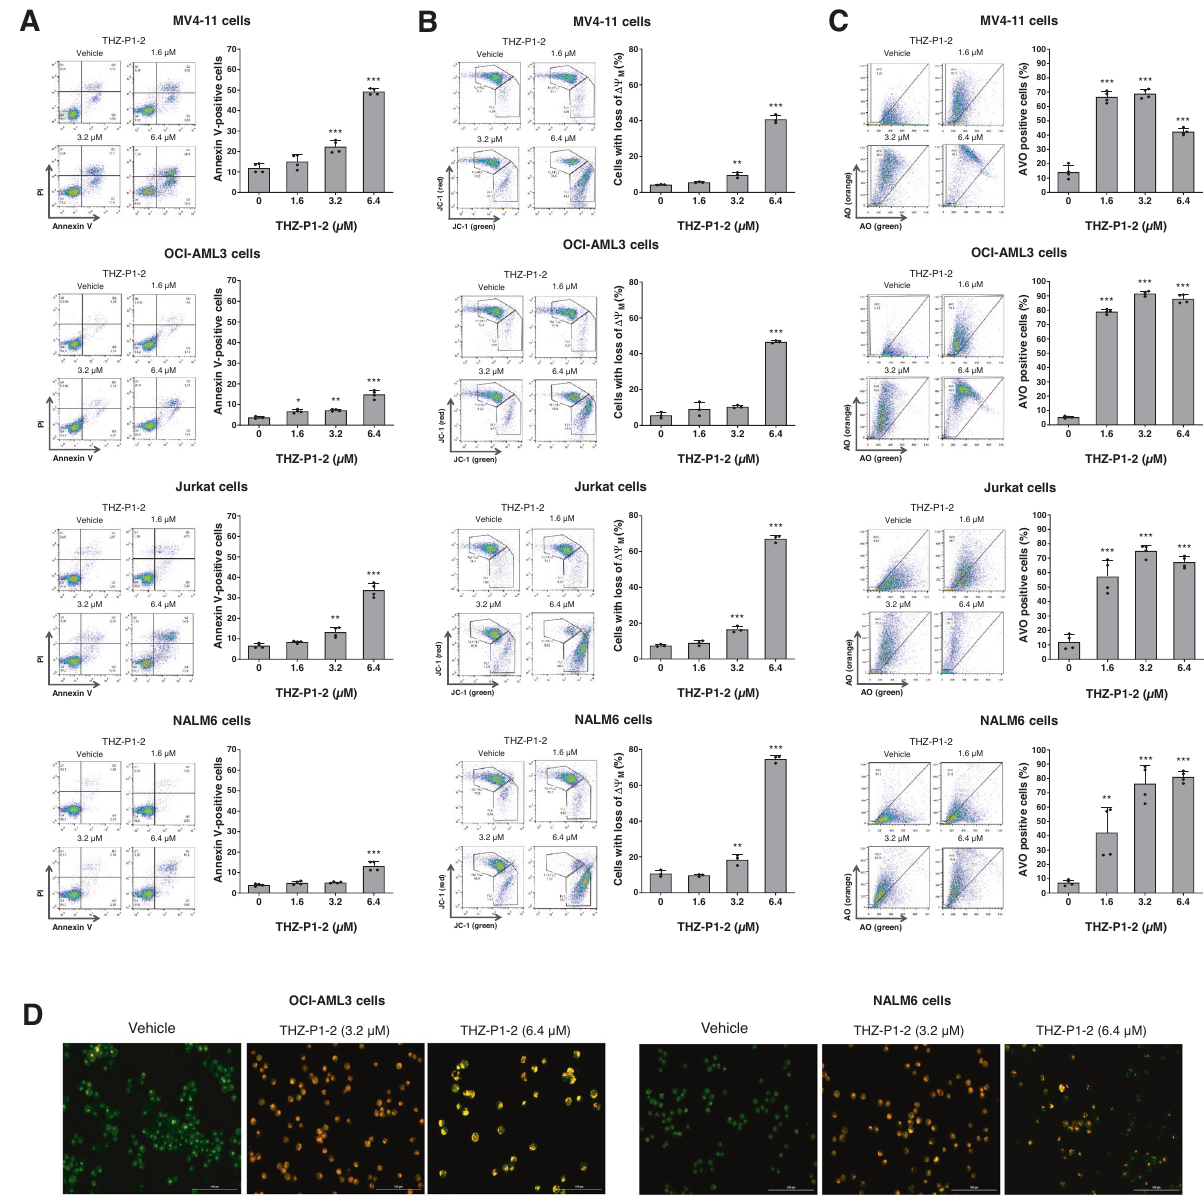
Fig. 2 THZ-P1-2 induces apoptosis and dysfunction in mitochondria and autophagic fl ux. A Apoptosis was detected by fl ow cytometry in MV4-11, OCI-AML3, Jurkat, and NALM6 cells treated with vehicle or with increasing concentrations of THZ-P1-2 (1.6, 3.2, and 6.4 μ M) for 24 h using an APC-annexin V/PI staining method. Representative dot plots are shown for each condition. The upper and lower right quadrants (Q2 plus Q3) cumulatively contain the apoptotic cell population (annexin V + cells). Bar graphs represent the mean ± SD of at least three independent experiments. The p values and cell lines are indicated in the graphs; * p < 0.05, ** p < 0.01, *** p < 0.0001; ANOVA and Bonferroni post-test. B Mitochondrial membrane potential ( ΔΨ M ) analysis was evaluated using the JC-1 staining method and fl ow cytometry. Leukemic cells were treated with vehicle or THZ-P1-2 (1.6, 3.2, and 6.4 μ M) for 24 h. Representative dot plots are shown for each condition; the gate FL-2 contains cells with intact mitochondria and the gate FL-2/FL-1 contains cells with damaged mitochondria. Bar graphs represent the mean ± SD of at least three independent experiments and the p values are indicated; ** p < 0.01, *** p < 0.0001; ANOVA and Bonferroni post- test. C The evaluation of acidic vesicular organelles (AVOs) was investigated through acridine orange (AO) labeling and fl ow cytometry in AML and ALL cell lines treated with vehicle or THZ-P1-2 (1.6, 3.2, and 6.4 μ M) for 24 h. Bar graphs represent the mean ± SD of at least three independent experiments and the p values are indicated; * p < 0.05, ** p < 0.01, *** p < 0.001; ANOVA and Bonferroni post-test. D